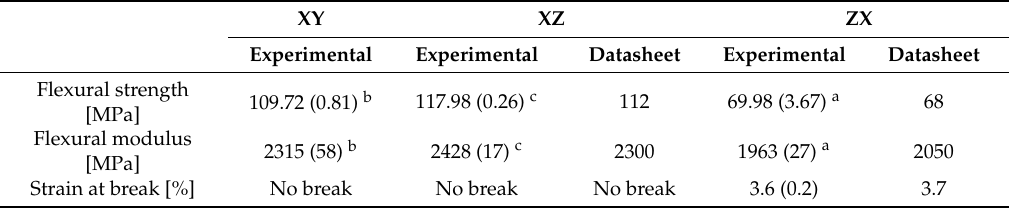
Table 5. Flexural properties of Ultem 9085 with XY, XZ, and ZX orientations, means, and standard deviations (in parentheses). Superscript letters indicate statistically homogeneous subsets (Tukey’s HSD test, α =